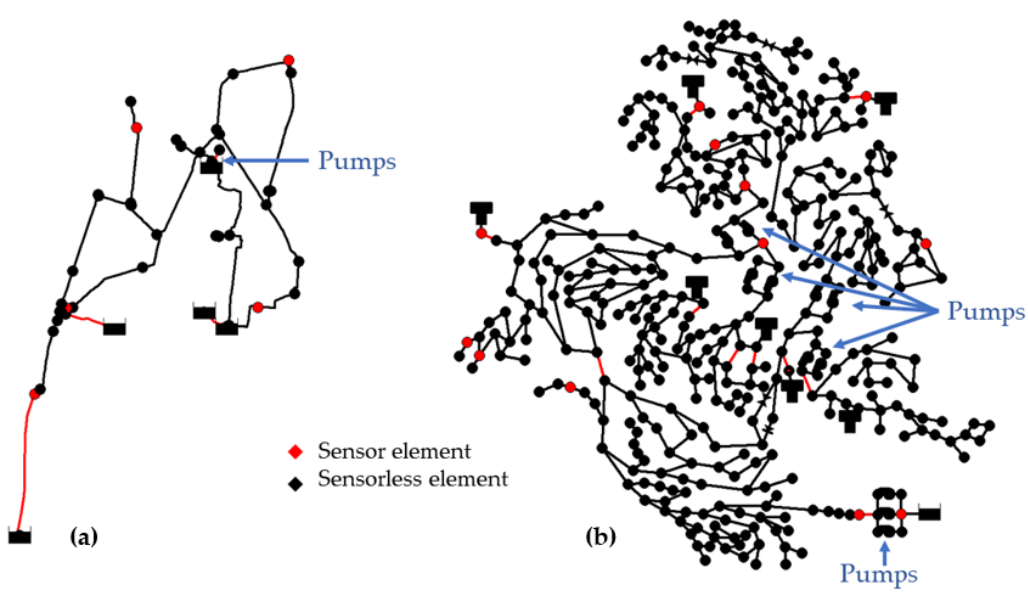
Figure 3. Topology and spatial distribution of sensors in ( a ) Patios-Villa del Rosario (Network 1), ( b ) C-Town (Network 2).